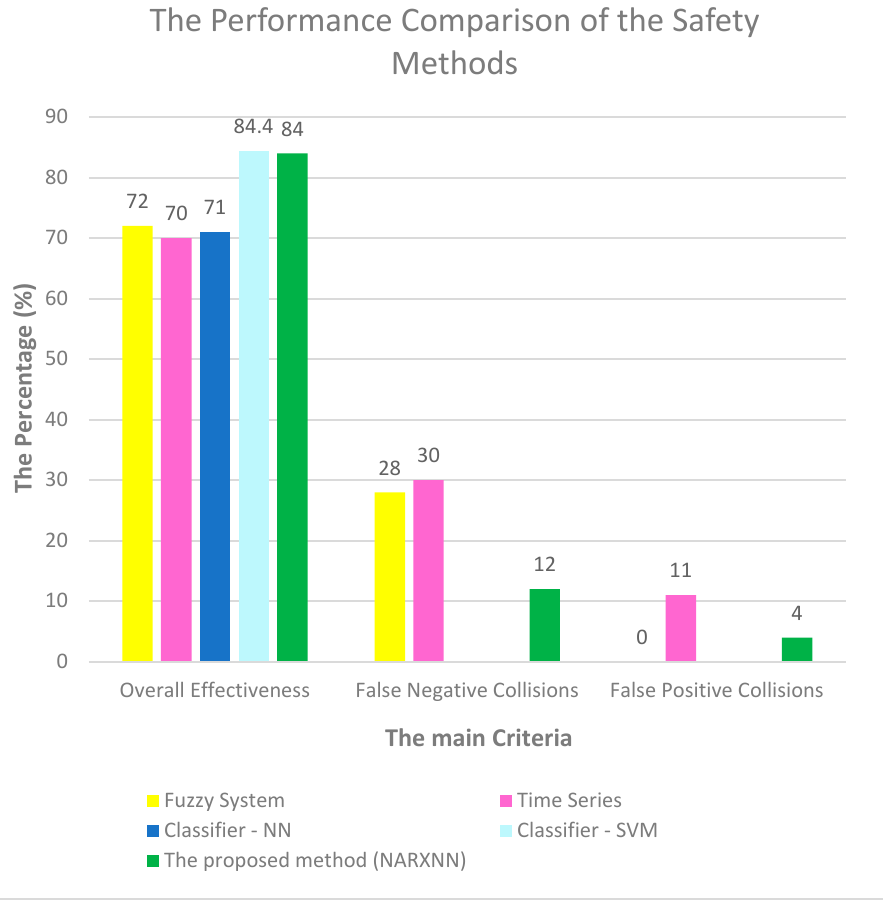
Figure 10. The comparison between the performance of the proposed method (NARXNN) and other previously related published methods.